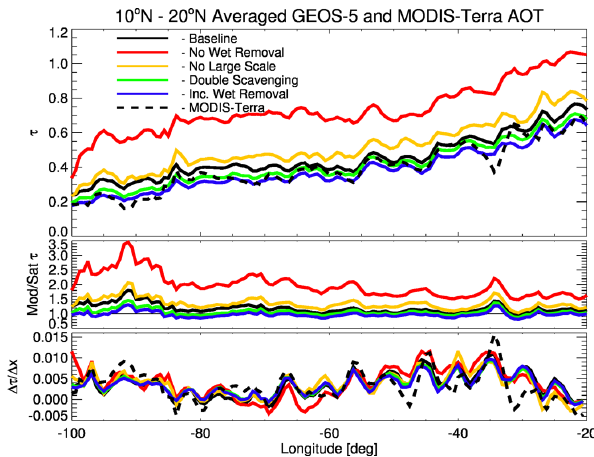
Fig. 14. 10 ◦ –20 ◦ N July 2007 mass budget for our baseline, no wet removal, no large-scale scavenging, doubled scavenging, wet removal treated as other aerosols sensitivity tests. Shaded region indicates integration region for the Central American dust barrier.